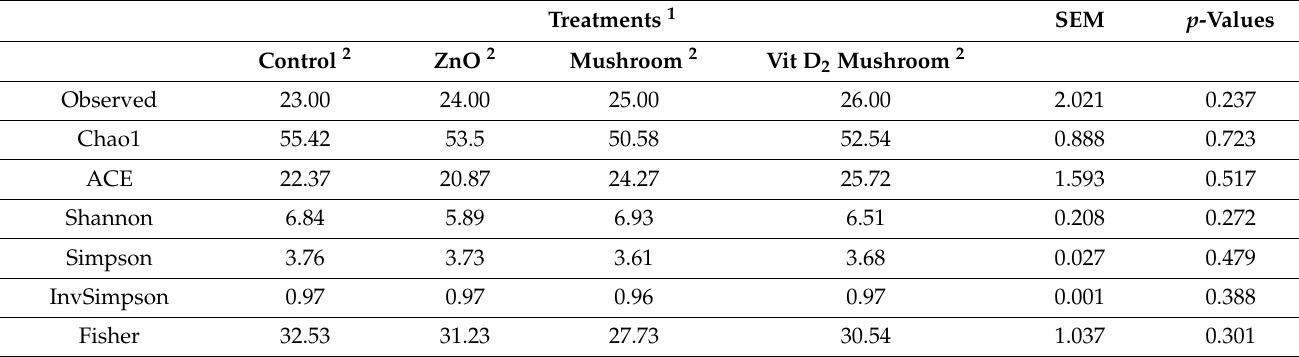
Table 5. The effect of dietary treatment on measures of alpha diversity (least-square means with their standard errors).